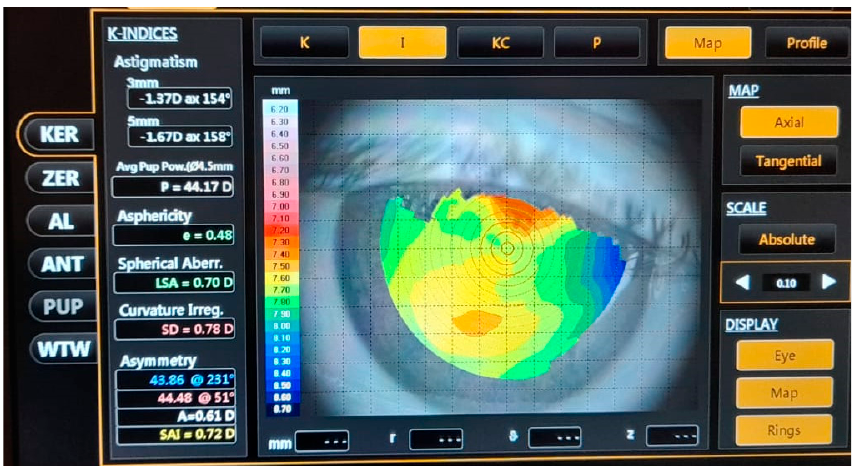
Figure 1. Map of the postoperative astigmatism measured using the Topcon Aladdin Optical Biometer and Corneal Topographer (Topcon Corporation, Tokyo, Japan).